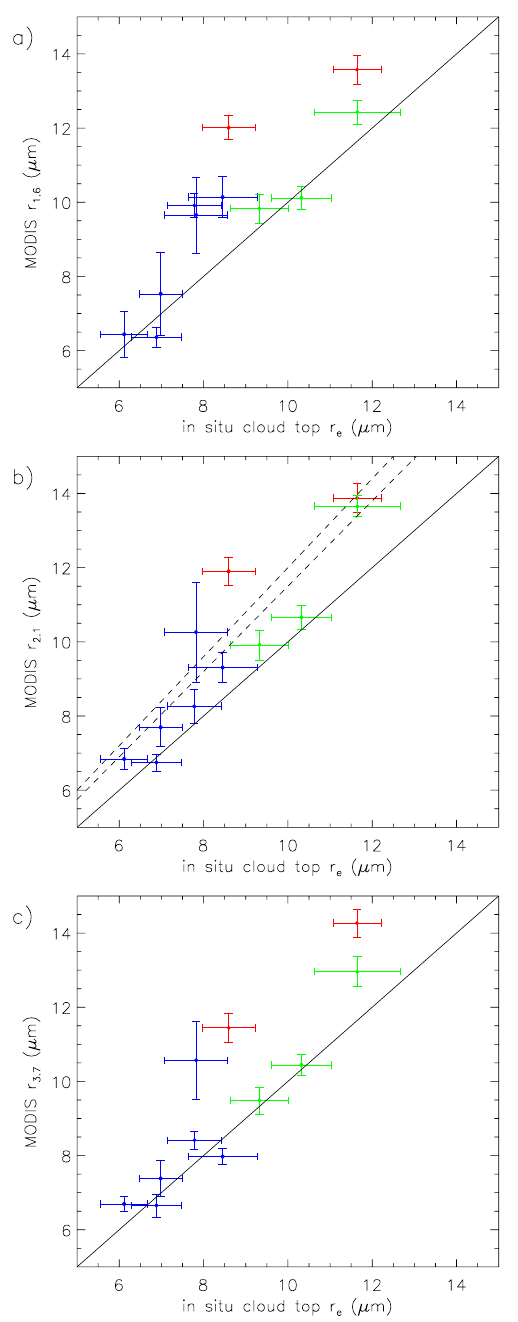
Fig. 3. Comparison of r e retrieved by MODIS using 1.6, 2.1, and 3.7µm channels (a,b and c respectively) and mean in situ measured r e in the top layer of the cloud within an optical depth of 1 from cloud top. Vertical error bars represent the standard deviation of the MODIS r e retrievals within the 5km × 5km domain used for the comparison. Horizontal error bars represent the propagated bin location calibration error. Red points are clouds whose 2DS LWPs were > 10gm − 2 , green points have a 2DS LWP in the range 1– 10gm − 2 and blue points have a 2DS LWP < 1gm − 2 . The dotted lines in (b) represent the 15–20% bias reported by Painemal and Zuidema (2011)